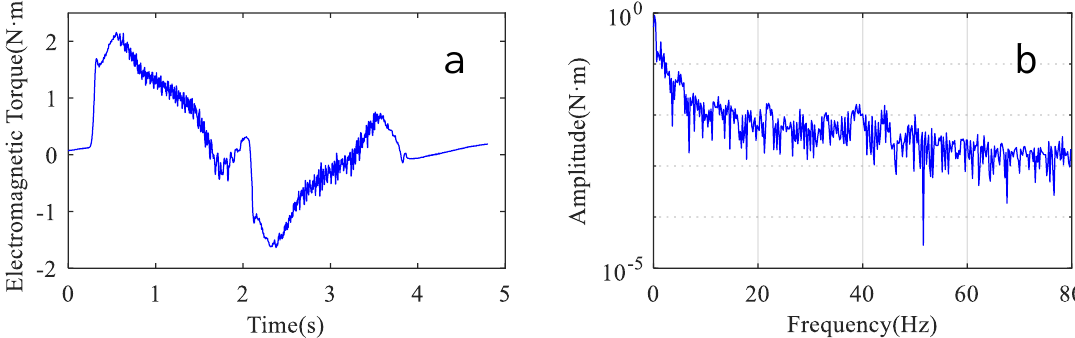
Figure 14. Motor electromagnetic torque signal. ( a ) waveform of the signal; ( b ) spectrum of the